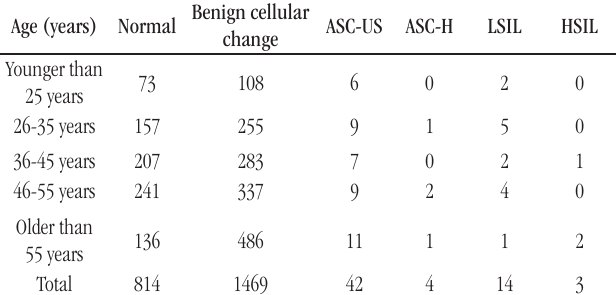
taBLE 2 − Comparison of age and cellular atypia Benign cellular Age (years) Normal ASC-US ASC-H change